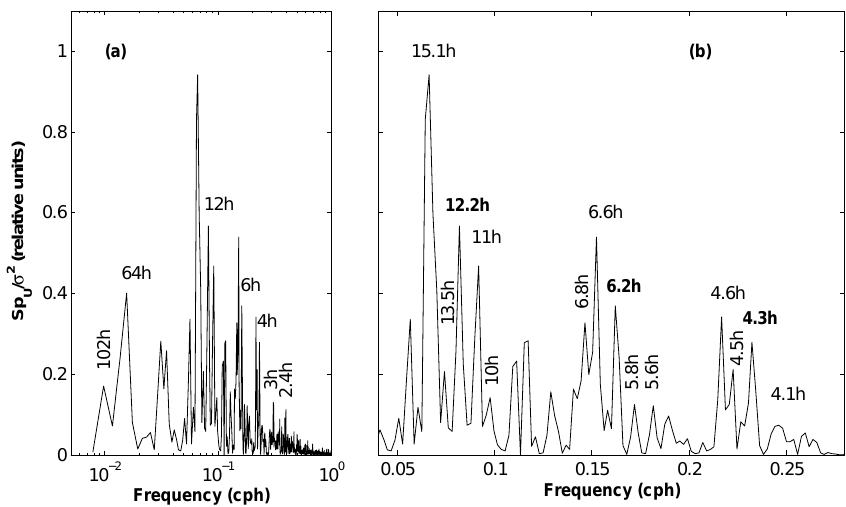
Fig. 4. (a) Normalized clockwise rotary spectrum of current versus log ω for currents measured at a depth of 35 m in the autumn of 1999. Numbers over the peaks are their periods. (b) The increased fragment of the spectrum surrounding the semidiurnal frequency. The bold numbers 12 . 2 , 6 . 2 and 4 . 3 are the carrier periods. Table 1. Periods of the peaks of the clockwise rotary spectrum (bold) and the calculated periods in hours